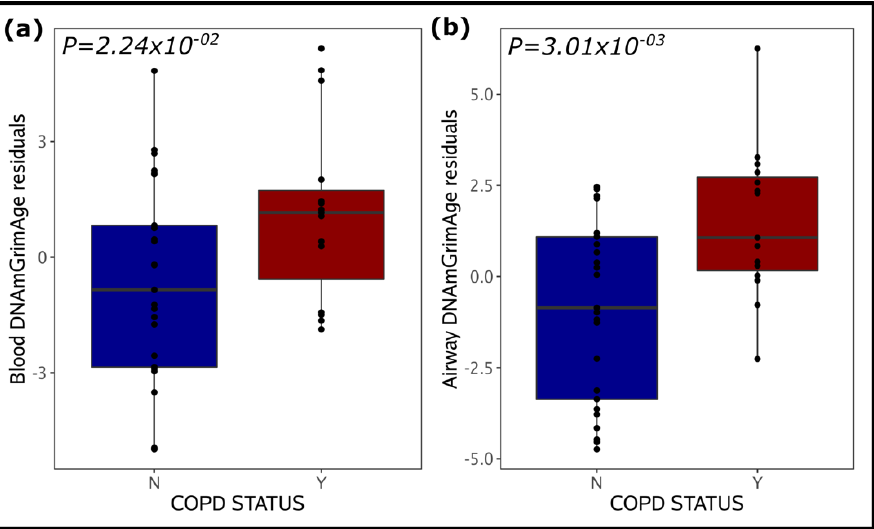
Figure 2. DNAmGrimAge age acceleration residuals in blood ( a ) and airway ( a ) samples and COPD. ( a , b ) show DNAmGrimAge age residuals based on COPD status (N = COPD negative, Y = COPD positive) ( x -axis). The y -axis on the plots represents the residuals obtained from the regression of methylation age on the chronological age, body mass index, sex, and smoking status. Blood analysis was further adjusted for blood cell composition Significant p -values ( p < 0.05) associated with the COPD status are shown inside the plots.